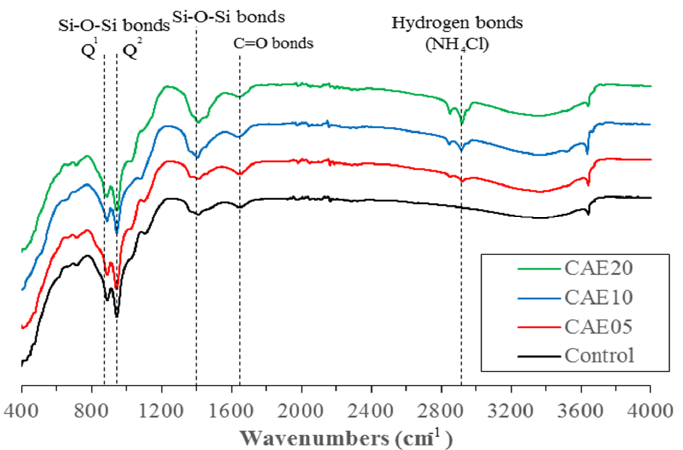
Figure 11. The FTIR spectra of the hybrid alkali-activated pastes with different CAE